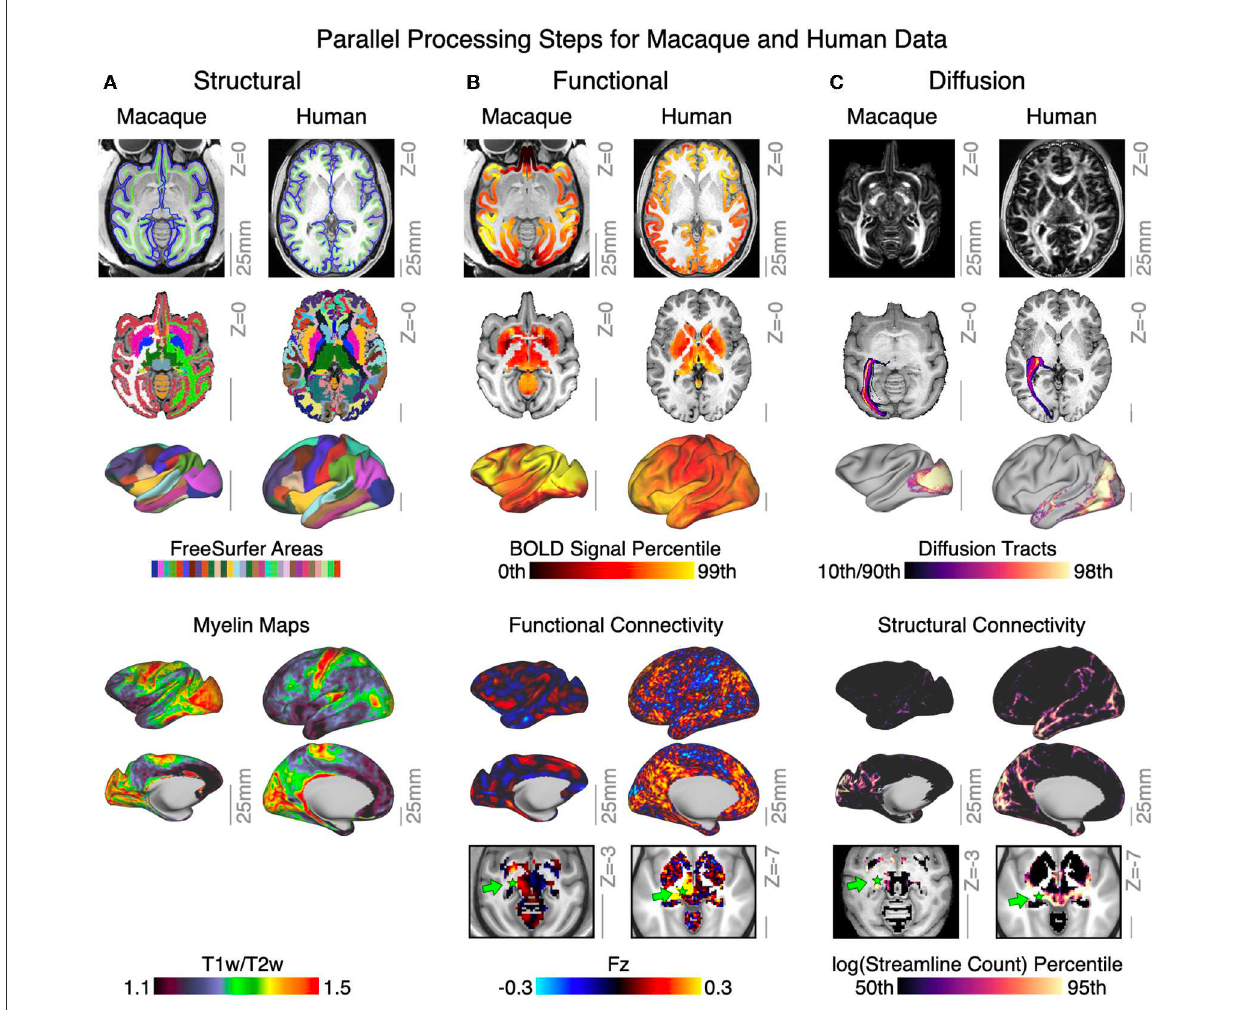
FIGURE6 QuNex enables neuroimaging workflows across different species. (A) Structural features for exemplar macaque and human data, including surface reconstructions and segmentation from FreeSurfer. Lower panel shows output myelin (T1w/T2w) maps. (B) Functional features for exemplar macaque and human showing BOLD signal mapped to both volume and surface. Lower panels show and resting-state functional connectivity seeded from the lateral geniculate nucleus of the thalamus (green arrow). (C) Diffusion features for exemplar macaque and human data, showing whole-brain fractional anistropy, and volume and surface terminations of the left optic radiation tract. Lower panels show the structural connectivity maps seeded from the lateral geniculate nucleus of the thalamus (green arrow). Gray scale reference bars in each panel are scaled to 25